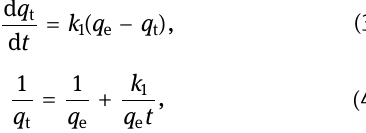
or Pb 2 + on pollen@FePO 4 microspheres. Sample: 50 mL, 40 mg · L − 1 Cd 2 + or 200 mg · L − 1 Pb 2 + , pH 5.92; adsorbent dose 0.3278